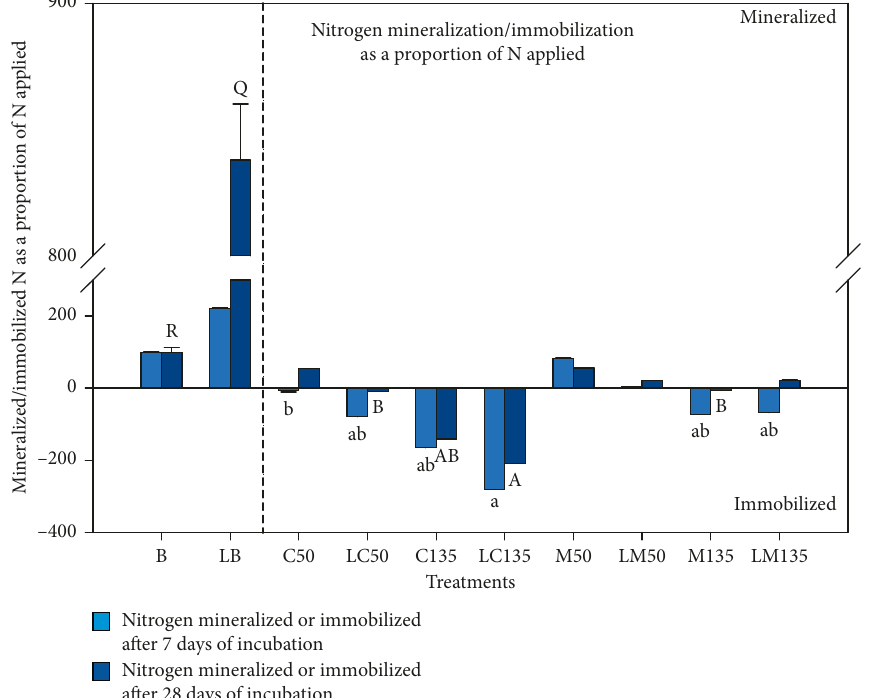
Figure 3: Treatments: bare control with no amendment (B), bare with LEM inoculant (LB), compost at 50kg · N · ha − 1 and at 135N · ha − 1 with and without LEM (C50, C135, LC50, and LC135), respectively, and mineral fertilizer at 50kg · N · ha − 1 and at 135N · ha − 1 with and without LEM (M50, M135, LM50, and LM135). B and LB treatments must be analyzed separately. While they have had day 0 nitrogen subtracted from their mineralized nitrogen values, because there was no N added to the pots, they have not been divided by any amount and are therefore on a much larger scale than the other treatments. Different lowercase letters indicate significant differences at day 7 of incubation. Different capital letters (A&B for amended treatments; Q&R for bare treatments) indicate significant differences at day 28 of incubation ( α � 0.10).